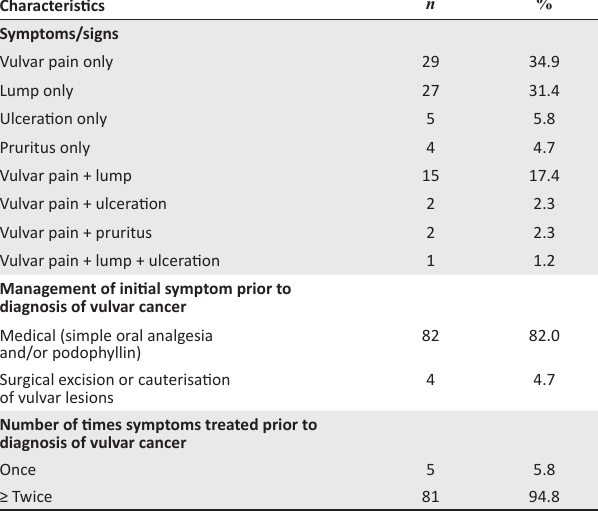
TABLE 3: Initial presenting symptoms, signs and